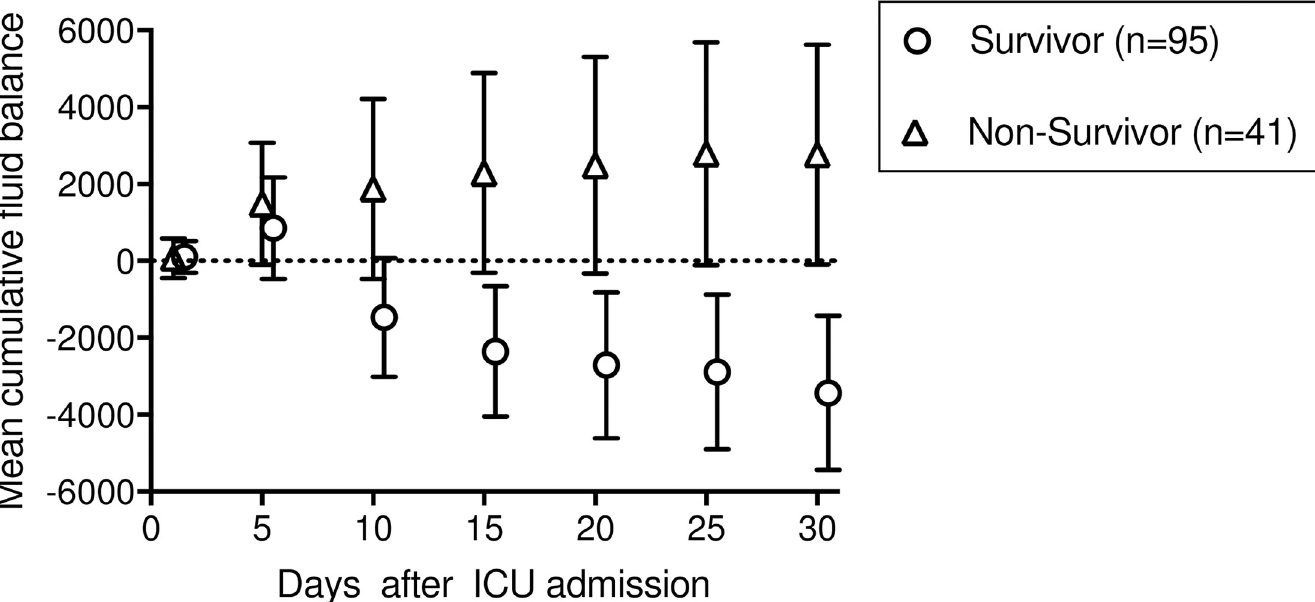
Fig 3. Mean cumulative fluid balance with 95% CI for survivors and non-survivors until ICU day 30. The fluid balance in patients who died was markedly greater than in the survivors.